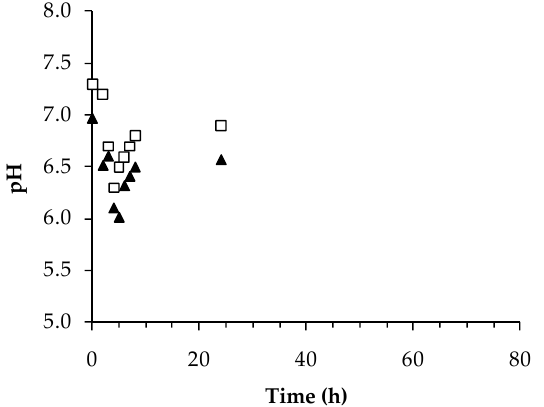
Figure 6. pH during syngas fermentation by C. carboxidivorans on Tryptone-Peptone-Yeast extract-Glucose-Arginine medium (TPYGarg) ( ▲ ) and ATCC ® 2713 ( □ ).